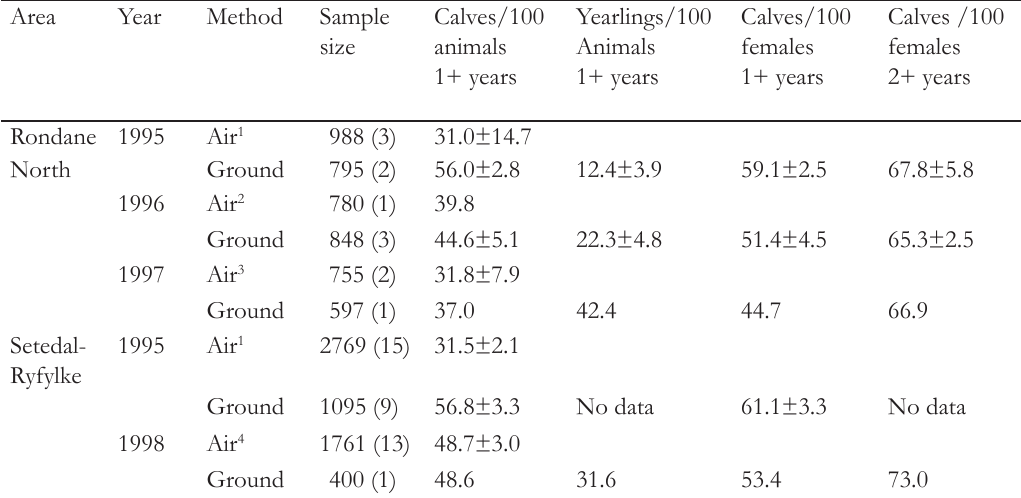
Table 2. Group composition (± SE) in wild reindeer groups ≥ 50 animals in wild reindeer herds in south - ern Norway estimated from ground counts and aerial photographs in June-July. Number of groups is in